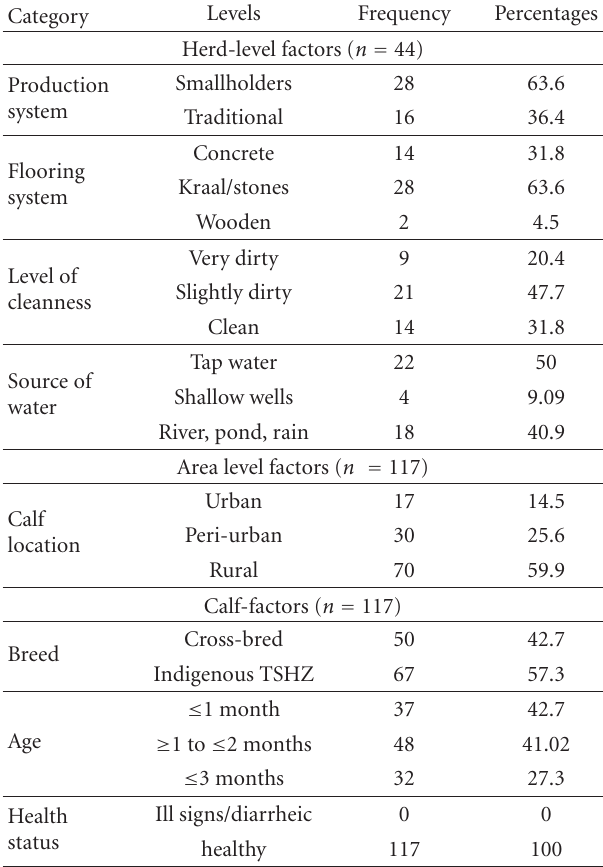
Table 1: Characteristics of the 117 selected calves in terms of animal- and herd-level variables from Tanga (May 2003–January